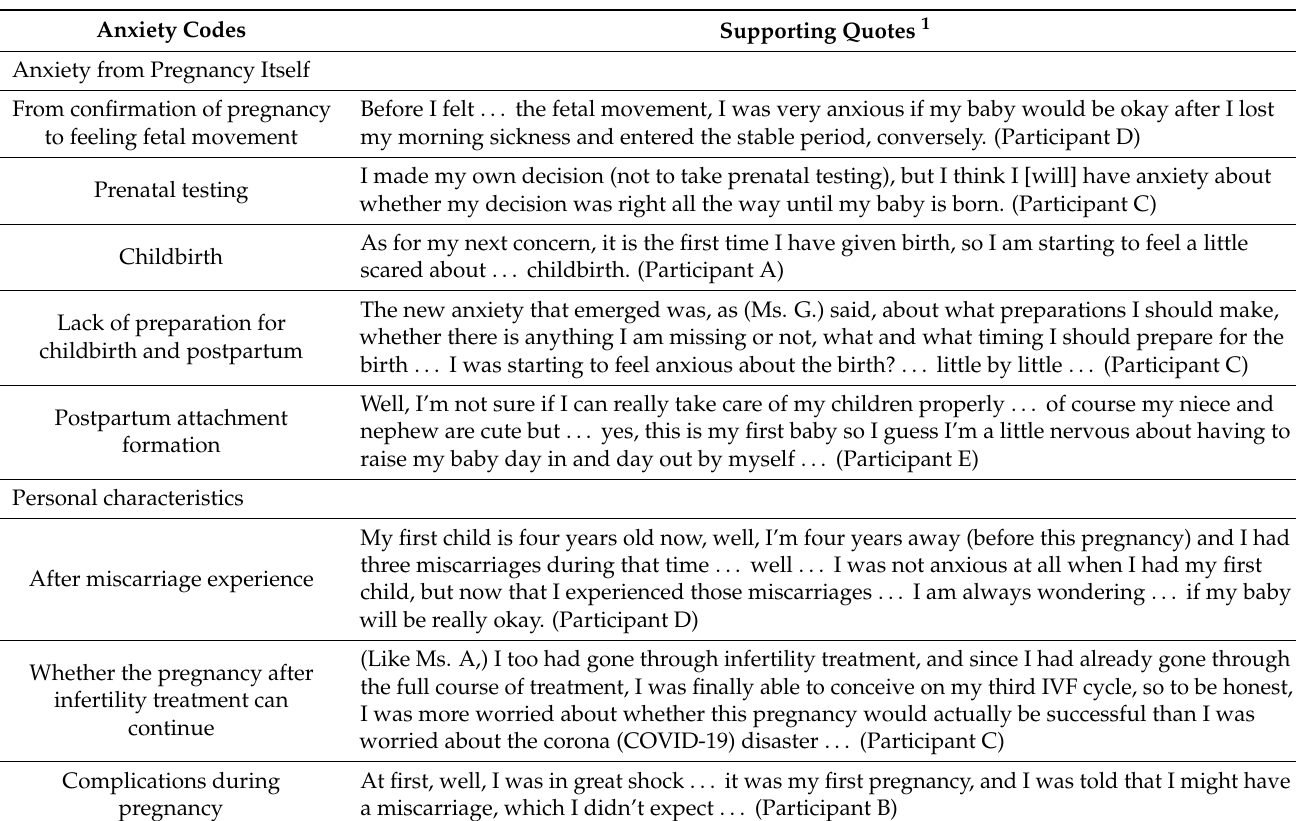
Table A1. Coded anxieties and supporting